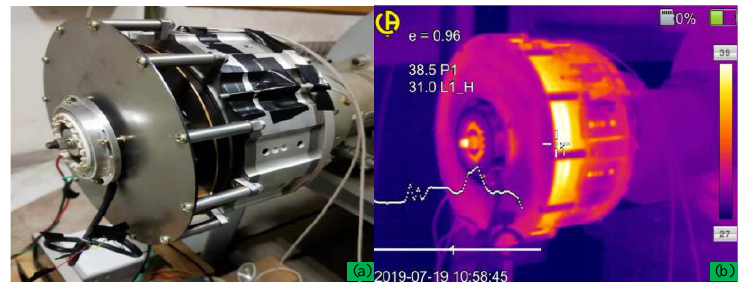
Figure 28. Non-driving end view of ISG and its thermal image at n = 3000 rpm ( a ) non-driver side, ( b ) thermal imaging figure.